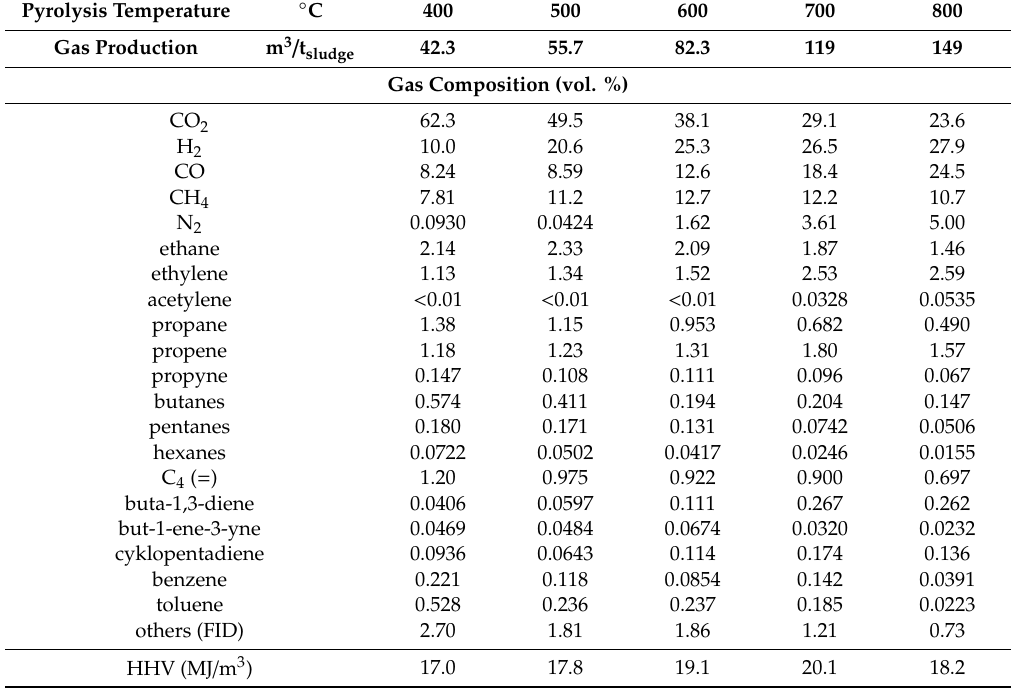
Table 2. Production, composition, and heating values of pyrolysis gases from sewage sludge pyrolysis. Main gaseous compounds were measured with 1% relative error, while trace components were measured with 4% relative